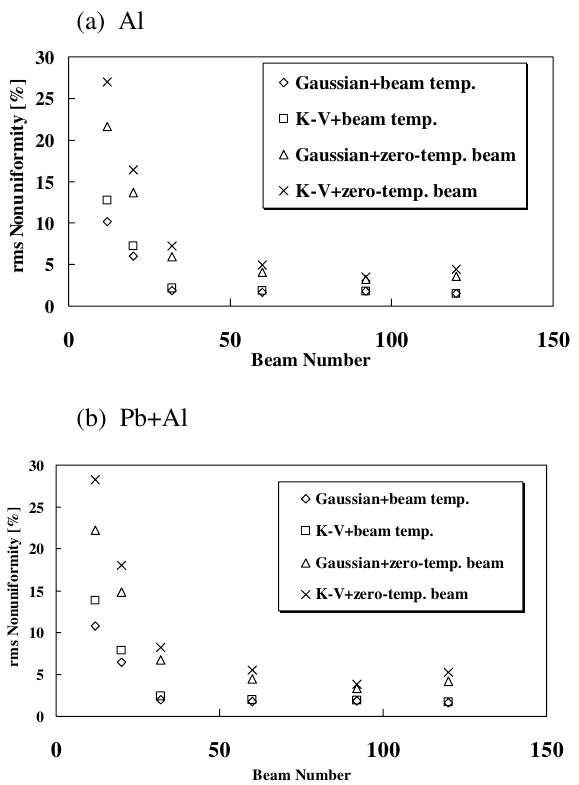
FIG. 14. The rms nonuniformity versus the HIB total number in the cases of (a) the Al layer target and (b) the Pb (cid:1) Al layer target with the chamber radius of 5 m. The marked diamonds, triangles, squares, and crosses mean the results in the cases of the Gauss distribution (G2) with and without the temperature effect, and of the semi-Gaussian distribution with and without the temperature effect, respectively.